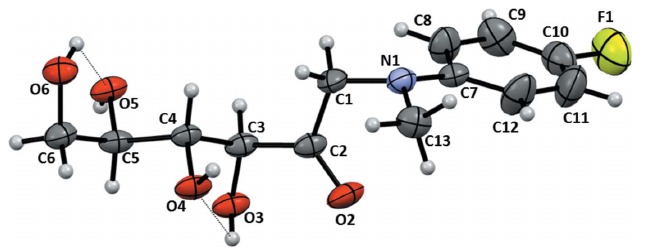
Figure 1 Atomic numbering and displacement ellipsoids at the 50% probability level for (I). Weakly directional intramolecular O—H (cid:2)(cid:2)(cid:2) O contacts are shown as dotted lines.